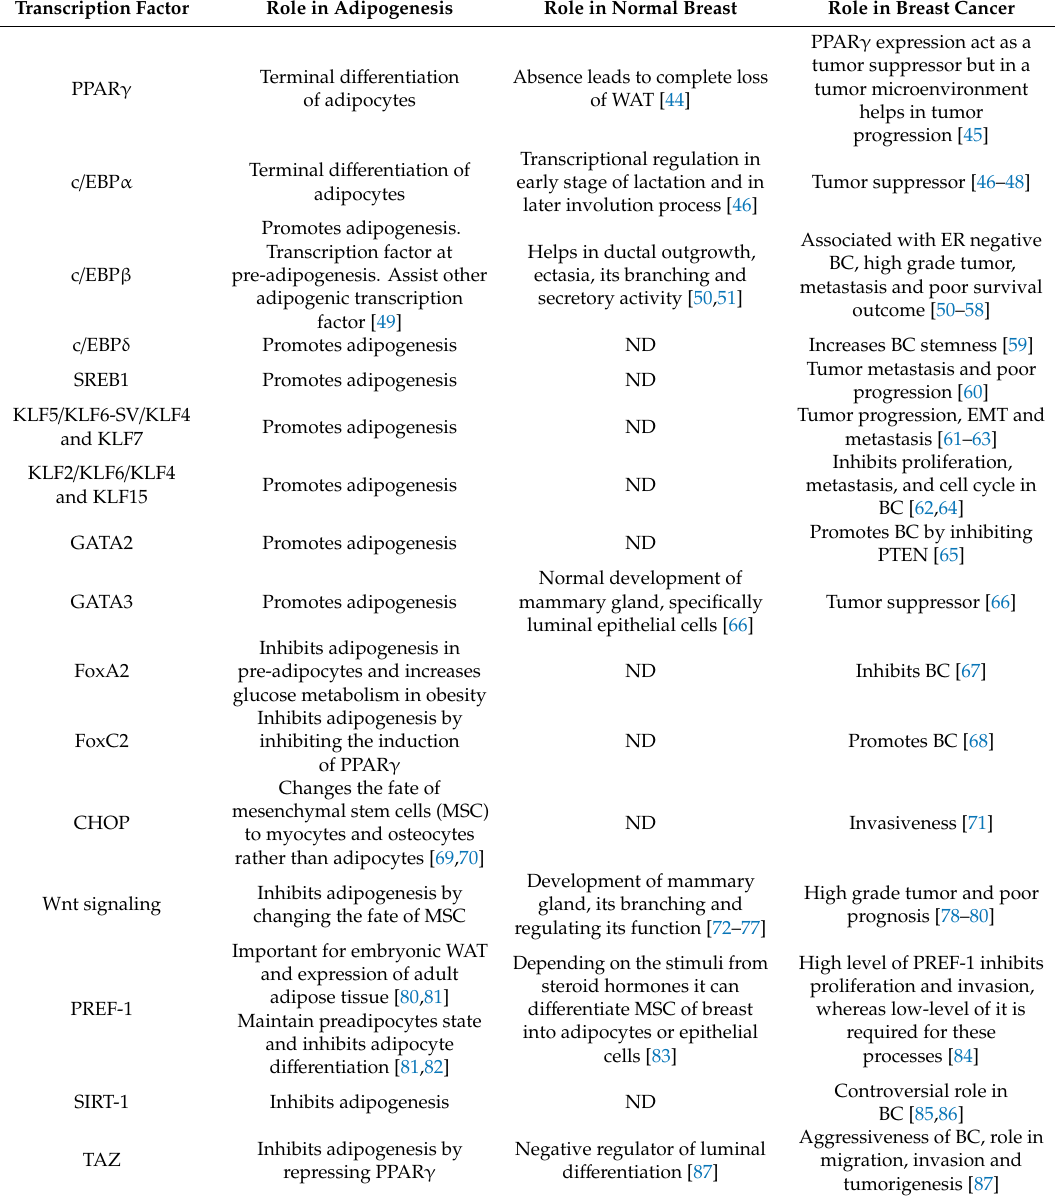
Table 1. The role of transcription factors in adipogenesis, breast development and breast